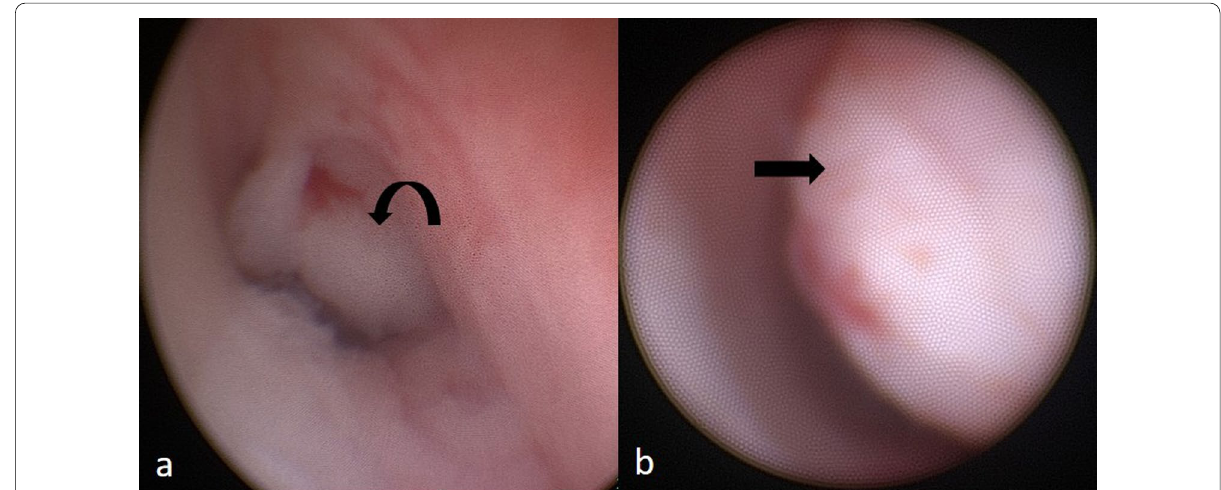
Fig. 2 Cystoscopic views of the penile urethra indented by an extrinsic, irregular mass (arrows)